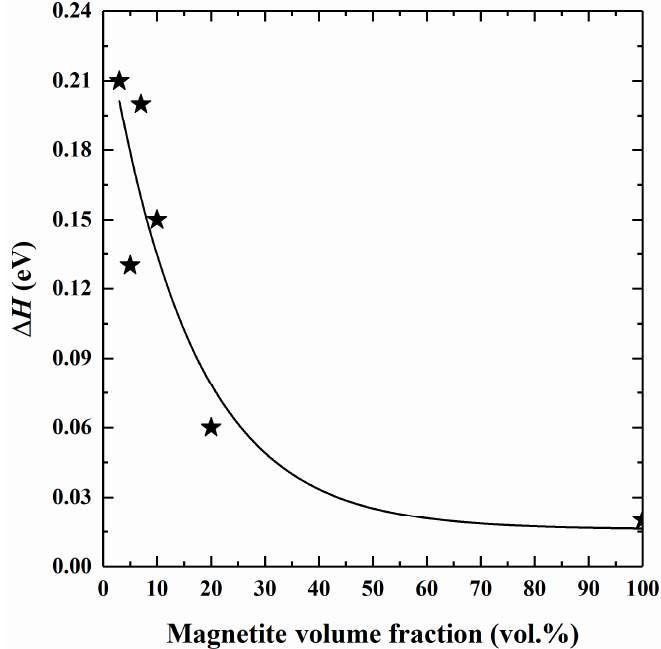
Figure 8. Dependence of the activation enthalpy ( Δ H ) on the volume faction of magnetite in olivine aggregates at 2.0 GPa and 873–1173 K.